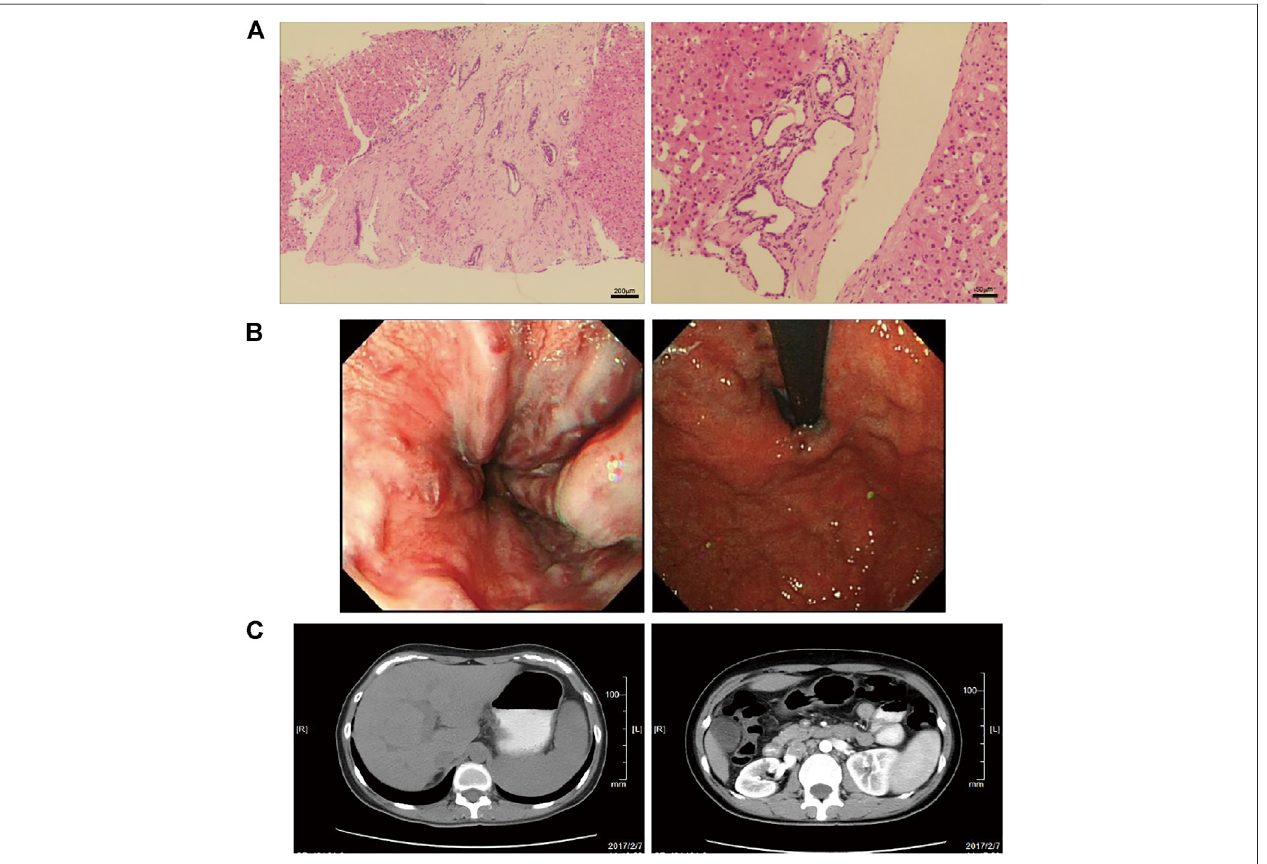
FIGURE 1 | The pathological and clinical presentation of one CHF patient with NCPH. (A) The left panel shows diffuse fi brosis in the liver. The right panel shows a small bile duct hamartoma. (B) Endoscopy showed esophageal varices (left) and gastric varices (right). (C) The abdomen CT images show slight dilatation of the intrahepatic bile duct and splenomegaly (left), and multiple renal cysts in the bilateral kidneys (right).